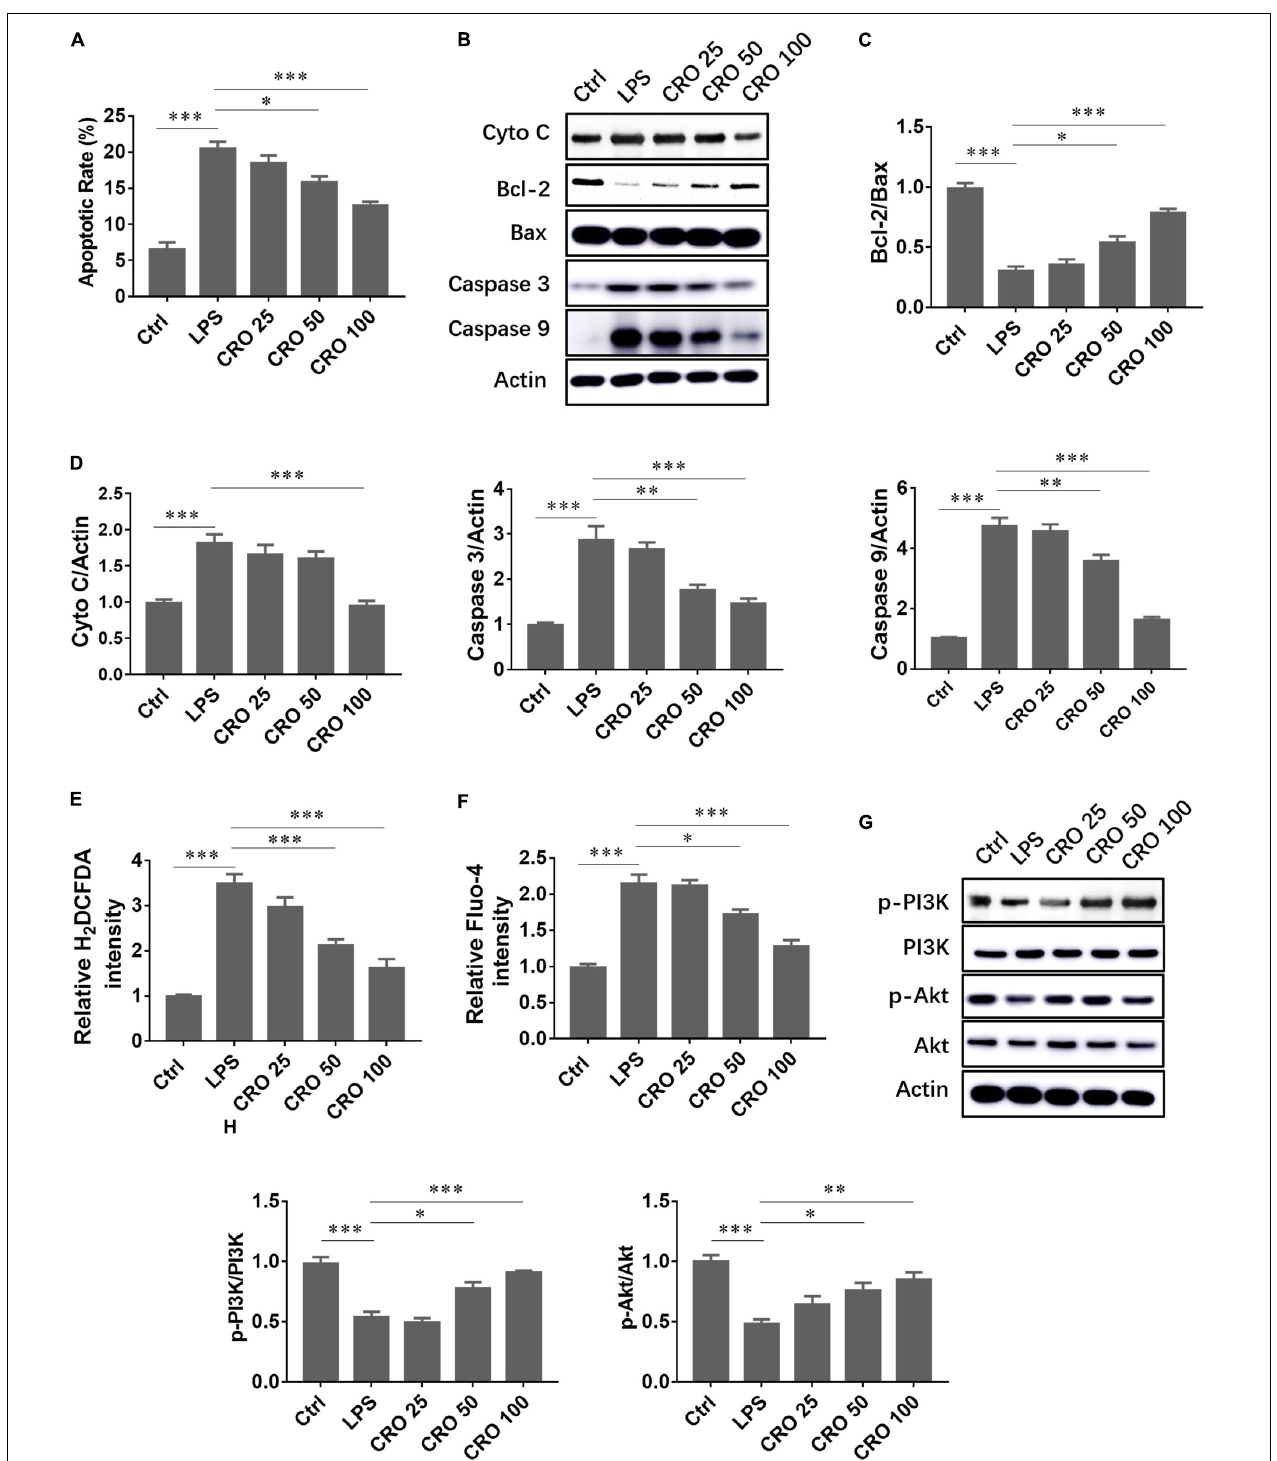
FIGURE 2 | Effect of CRO on cell apoptosis and cell survival in LPS-induced cardiac sepsis. (A) Effect of CRO on rate of apoptosis in LPS-induced H9c2 cells. Data ( n = 3) are presented as the mean ± SEM, *p < 0.05, *** p < 0.001. (B) Effect of CRO on the expression of cytochrome c, Bcl-2, Bax, caspase 3, and caspase 9 in LPS-induced H9c2 cells. The ratios of Bcl-2 to Bax and quantitation of cytochrome c, caspase 3, and caspase 9 are summarized in panels (C,D) , respectively. Data ( n = 3) are presented as the mean ± SEM, *p < 0.05, **p < 0.01, *** p < 0.001. (E,F) Effect of CRO on ROS (indicated by H 2 DCFDA) and Ca 2 + (using Fluo-4 as an indicator) levels as determined using flow cytometry in LPS-induced H9c2 cells. Data ( n = 3) are presented as the mean ± SEM, *p < 0.05, ***p < 0.001. (G) Effect of CRO on the expression of p-PI3K, PI3K, p-Akt, and Akt in LPS-induced H9c2 cells. Levels of these proteins were quantitated and are presented in panel (H) . Data ( n = 3) are presented as the mean ± SEM, *p < 0.05, ***p < 0.001.